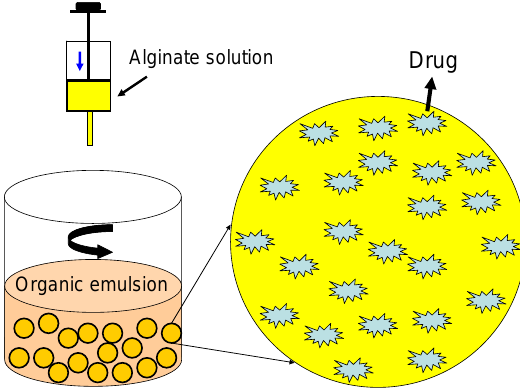
Figure 7. Illustration of the procedure for alginate solid-spheres in loading